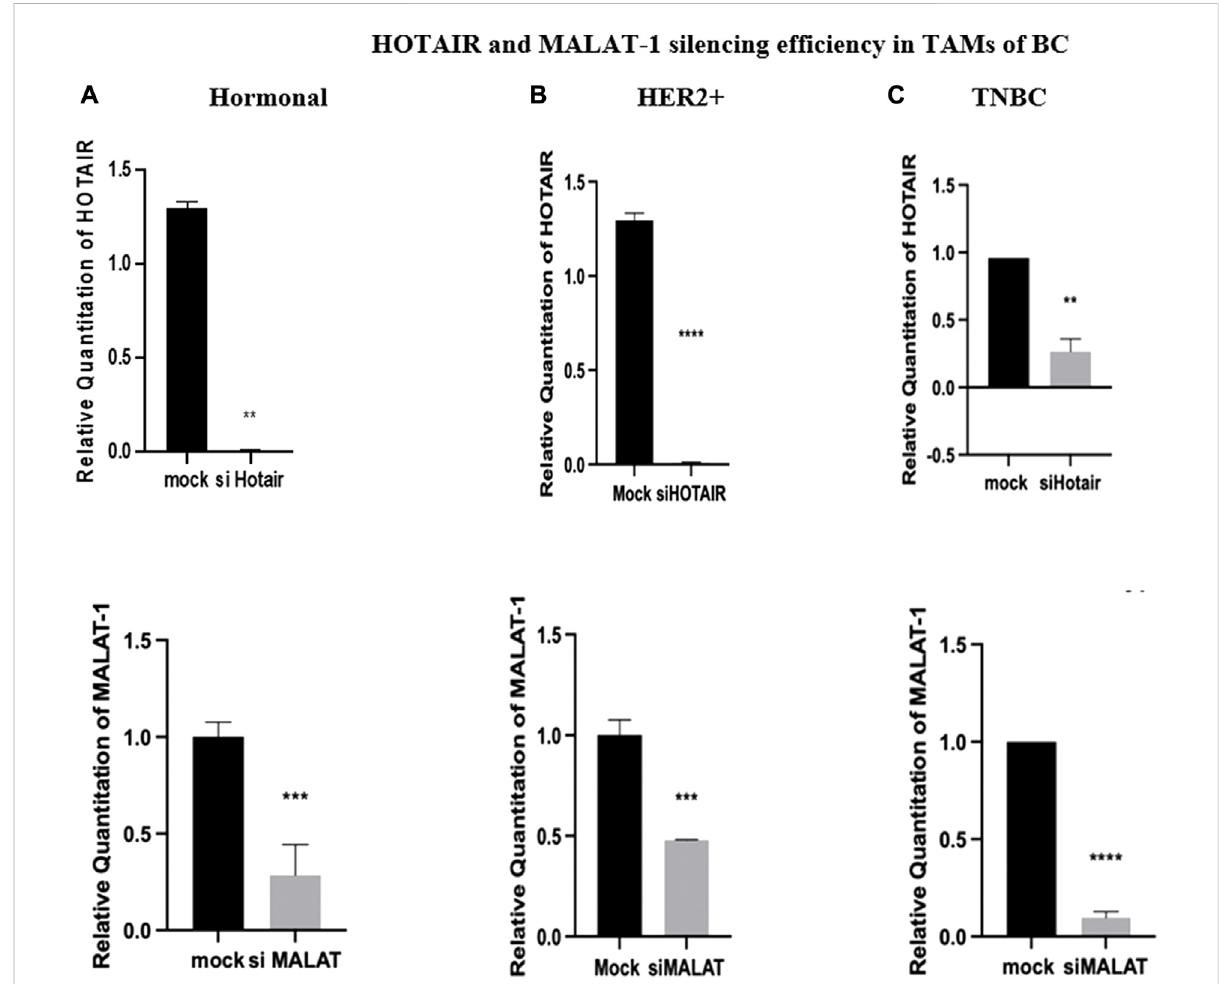
FIGURE 3 HOTAIRandMALAT1silencingef fi ciency inTAMsof (A) hormonal, (B) HER2+, and (C) TNBC.q-PCRwasperformedforthequantitative analysis of the HOTAIR and MALAT1 levels. Transfection with silencers against HOTAIR resulted in a decrease in expression with a rate of approximately 1.29 folds in both hormonal and HER2+, while a decrease in expression with a rate of approximately 0.75 folds in TNBC compared to the normal untransfected controls (mocks). With a similar pattern of expression, transfection with silencers against MALAT1 resulted in a decrease in expression with a rate of approximately 0.8 folds in hormonal, 0.5 folds in HER2+, and 0.9 folds in TNBC compared to the normal untransfected controls (mocks). Thus, the ef fi ciency of silencing of HOTAIR and MALAT1 was con fi rmed. Parametric student t -test was used for comparing two groups. **** = p < 0.0001, *** = p < 0.001, ** = p < 0.01, * = p < 0.05, and ns = statistically not signi fi